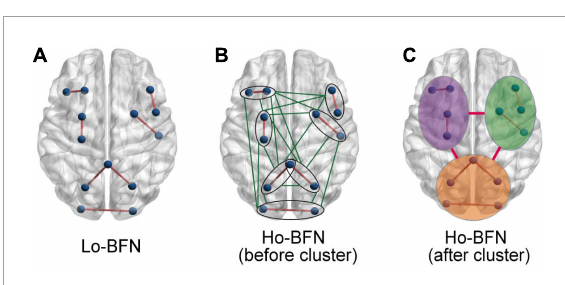
FIGURE3 Schematic diagram of different BFNs. (A) Schematic diagram of the brain region of LO-BFN. (B) Schematic diagram of brain regions of HO-BFN before clustering. (C) Schematic diagram of brain regions of HO-BFN after